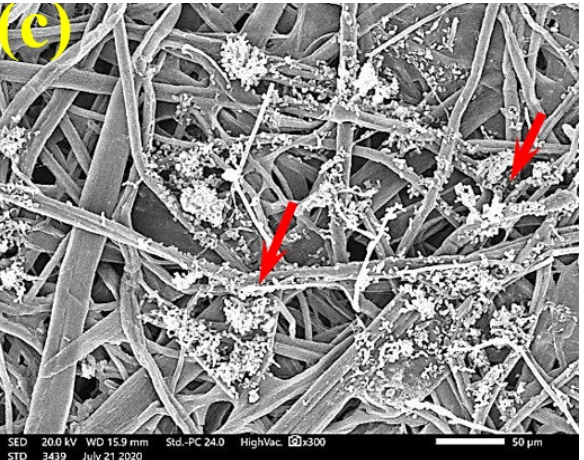
Figure 9. SEM images of the paper sheets manufactured from ( a ) B. speclabilis , ( b ) F. altissima , and ( c ) F. elastica treated with 10% DMSO (control) and inoculated with S. solani . Arrows refer to dense growth of fungal mycelia in sample fibers.